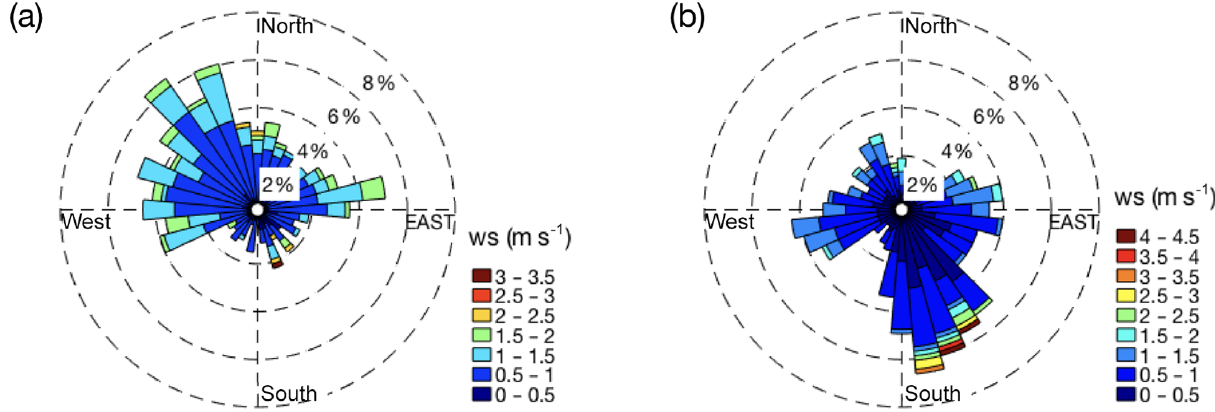
Figure A4. Wind roses for (a) daytime (09:00–15:00) and (b) nighttime (21:00–03:00) for non-NPF event days. The lengths of the wedges show the frequency of each wind direction, and the colors illustrate the frequency of different wind speed values (ws).